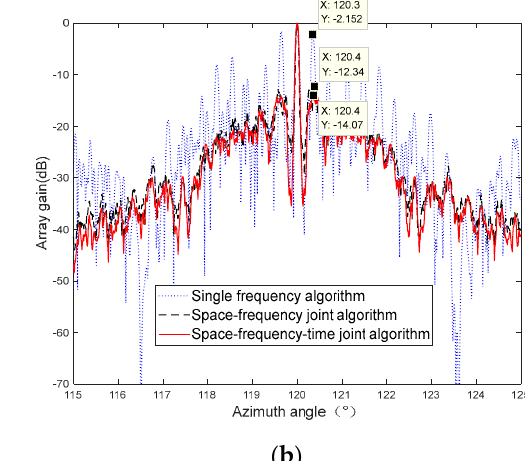
( b ) Figure 10. The beampattern under elevation angle of 30 and azimuth angle of 120. ( a ) The elevation pattern; ( b ) the azimuth pattern.